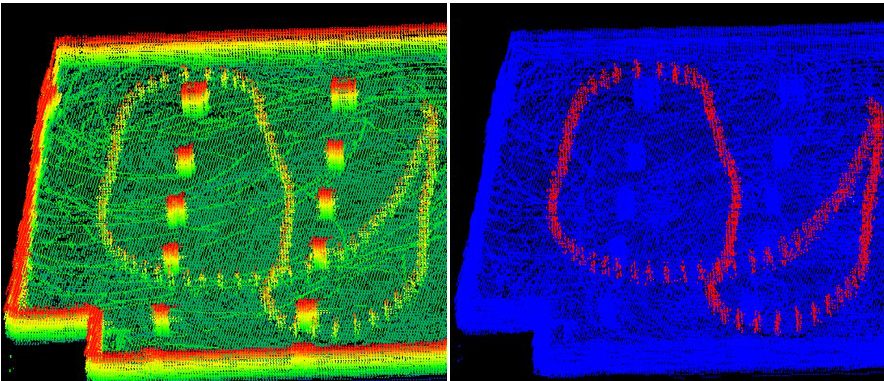
Figure 13. ( Left ) Part of the original point cloud map. ( Right ) Annotations of dynamic objects (red points) and static parts (blue points) in the map.